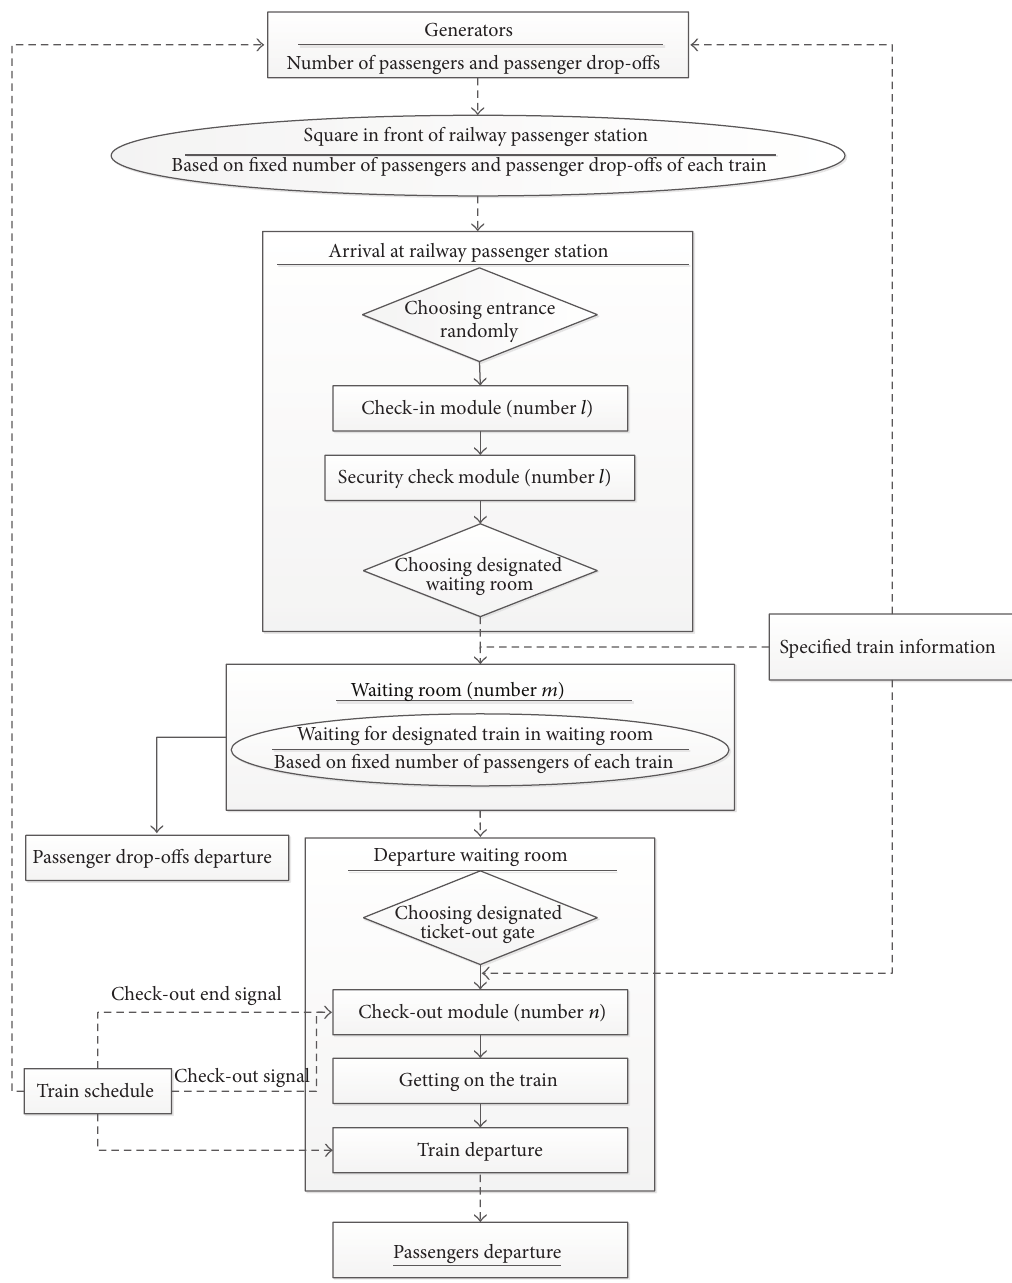
Figure 4: Simulation process of operation of railway passenger